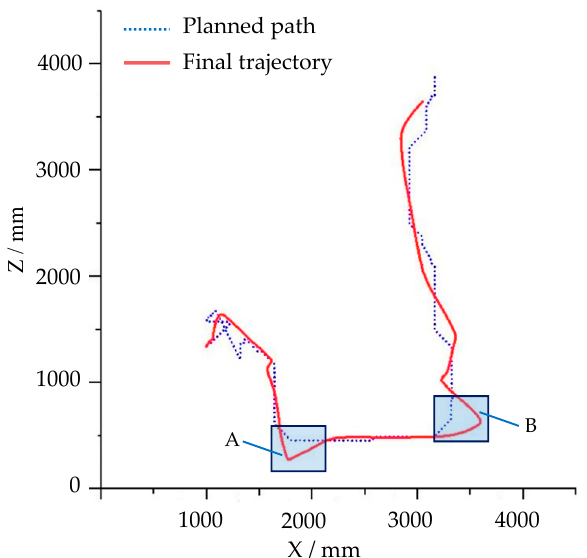
Figure 38. The planned path and final trajectory of the robot in the navigation simulation in the dynamic environment shown in Figure 37.